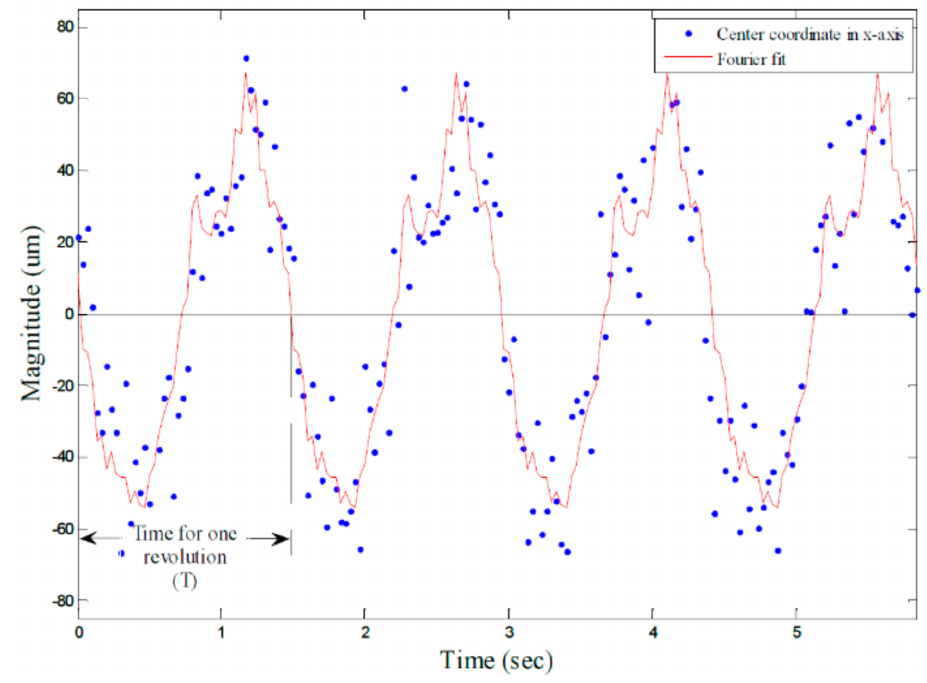
Figure 35. Fourier series analysis of the circle centre data in X direction